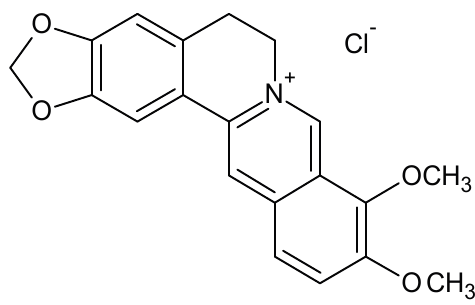
Figure 3. Chemical (molecular) structure of the berberine derivative berberine chloride salt, containing a protoberberine skeleton and nitrogen cation ion. Modifications of the berberine molecule leads to its derivatives exhibiting valuable pharmacological